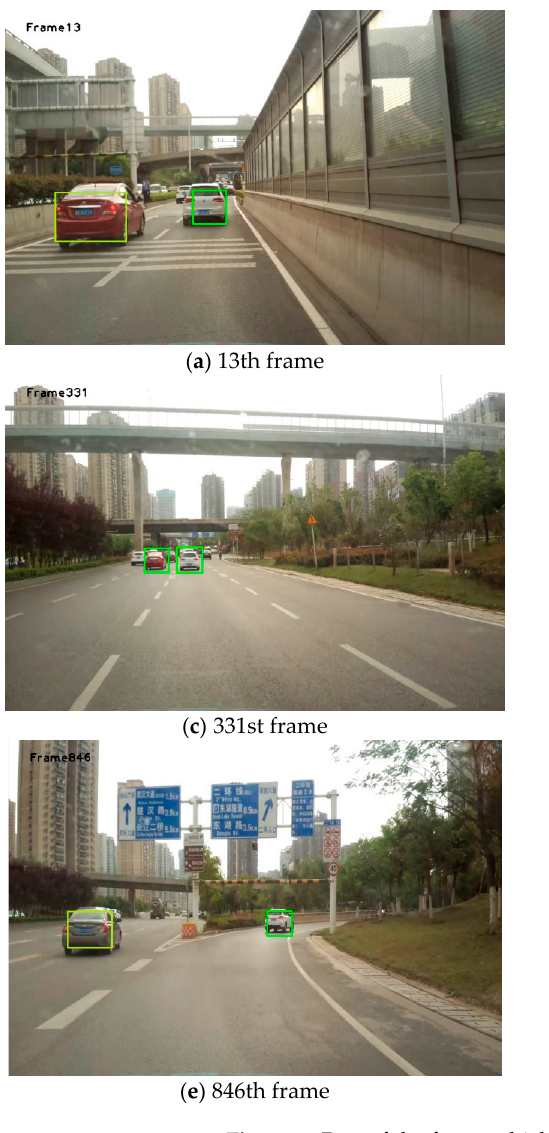
Figure 8. Part of the front-vehicle detection results in Video 1.